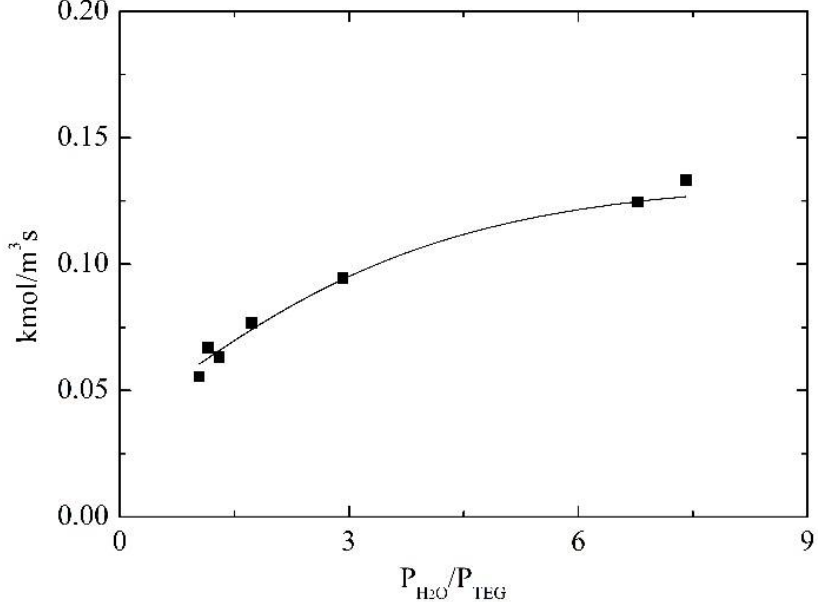
Figure 8. Effect of ratio of pressure on mass transfer coefficient. ( (cid:4) : data concerning the changed concentration and temperature of the TEG solution).